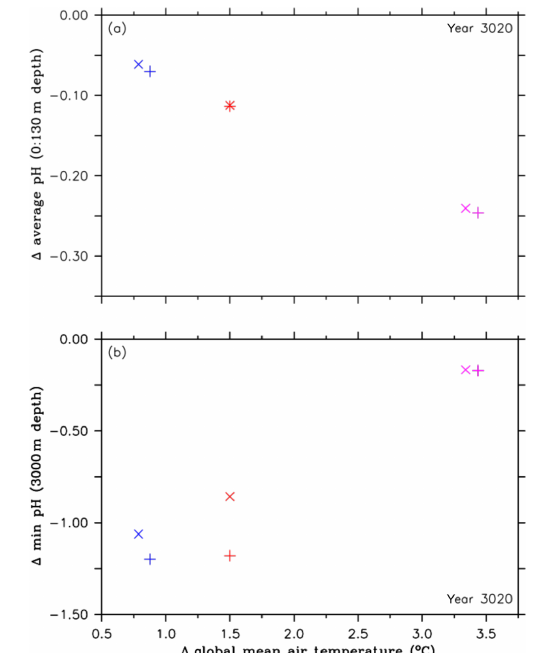
Figure 4. Comparison of pH values and their corresponding global mean temperatures in the year 3020, both relative to preindustrial levels, between the RCP4.5 control simulations (purple symbols), simulations of the second approach (A2, red symbols), and simula- tions of the third approach (A3, blue symbols). The cross symbols refer to the default simulations, and the X symbols denote sim- ulations with CaCO 3 sediment and weathering feedbacks. These symbols represent (a) changes in the ocean surface pH (0 to 130m depth), relative to preindustrial levels, and (b) changes in minimum pH values at 3000m depth, relative to preindustrial